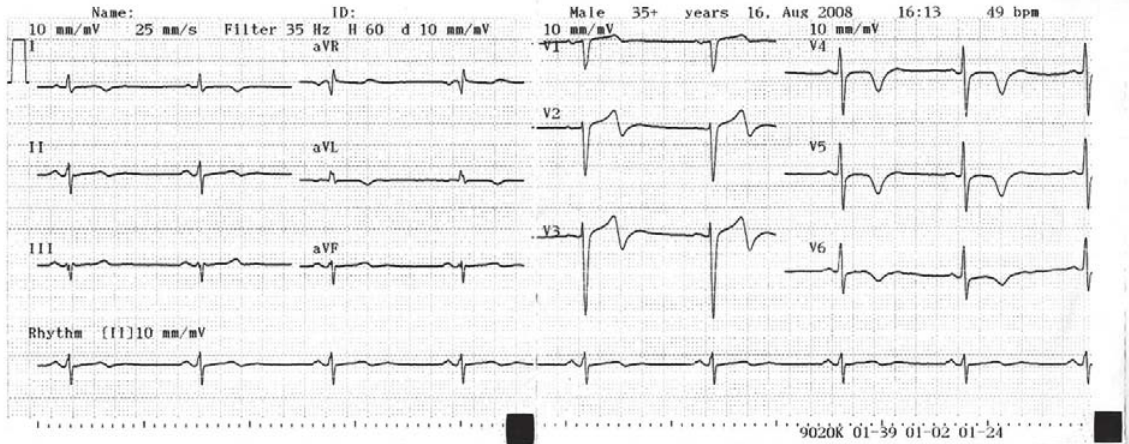
Fig. 2 - Eletrocardiograma pré-operatório: isquemia anterior